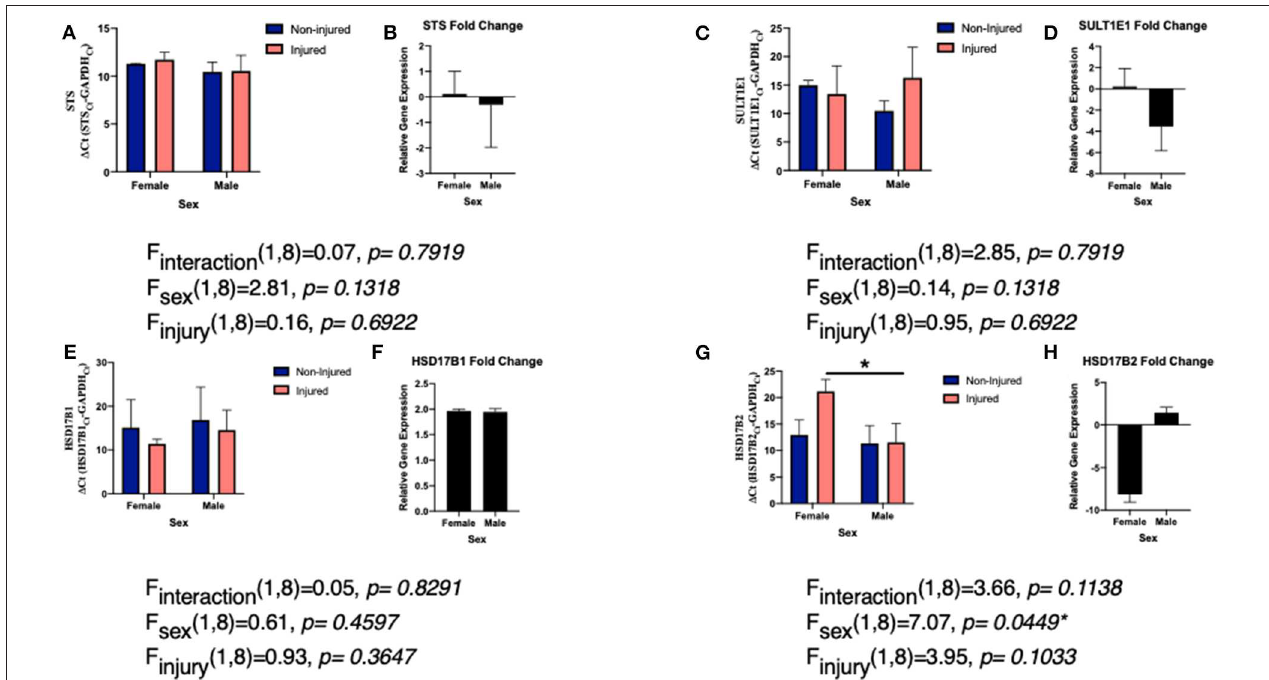
FIGURE 2 | Levels of EMEs mRNA relative to glyceraldehyde-3-phosphate dehydrogenase (GAPDH; delta CT value and fold change) in both male and female zebra finches 24h post-surgery. Adult male and female zebra finches were subjected to an unilateral penetrating injury directed toward the entopallium and collected 24h later. Finches were sacrificed and total RNA was extracted from microdissections immediately adjacent to the cortical needle and the corresponding location on uninjured hemisphere. Expression of STS (A) , SULT1E1 (C) , HSD17B1 (E) , and HSD17B2 (G) relative to GAPDH was measured using quantitative PCR using primers specific for the ZF mRNA sequence. Mean 1 CT values were compared with a two-way ANOVA. Fold change in gene expression was also calculated STS (B) , SULT1E1 (D) , HSD17B1 (F) , and HSD17B2 (H) . Neither expression of STS, SULT1E1, or HSD17B1 were significantly changed following injury. However, HSD17B2 was significantly downregulated following injury. *denotes a significant difference at P < 0.05. All protocols were approved by the Vassar College Institutional Animal Care and Use Committee following National Institutes of Health